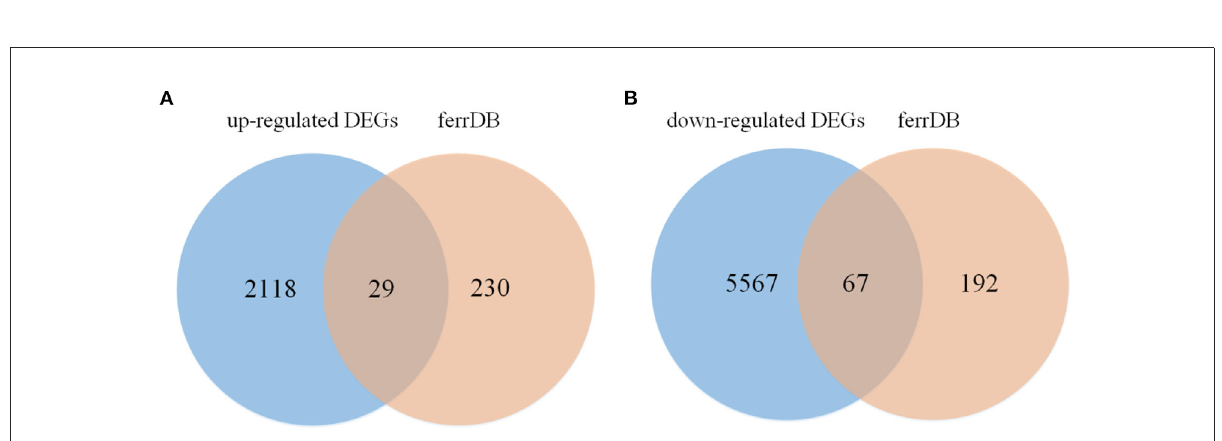
FIGURE3 Venn diagram displaying the DE-FRGs. (A) The venn of up-regulated DE-FRGs. (B) The venn of down-regulated DE-FRGs.